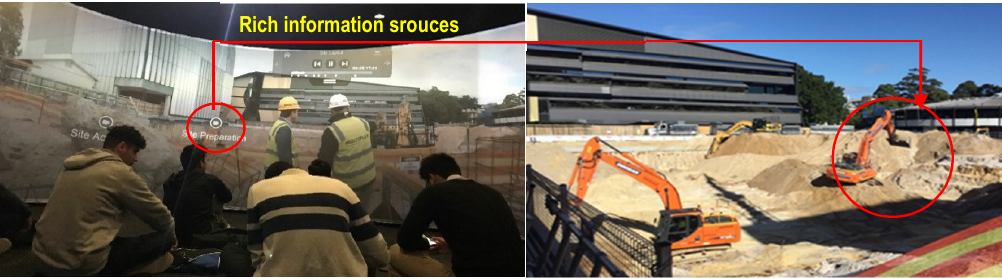
Figure 7. The main computer is running the module in a separate control room. Appl. Sci. 2020, 10, x